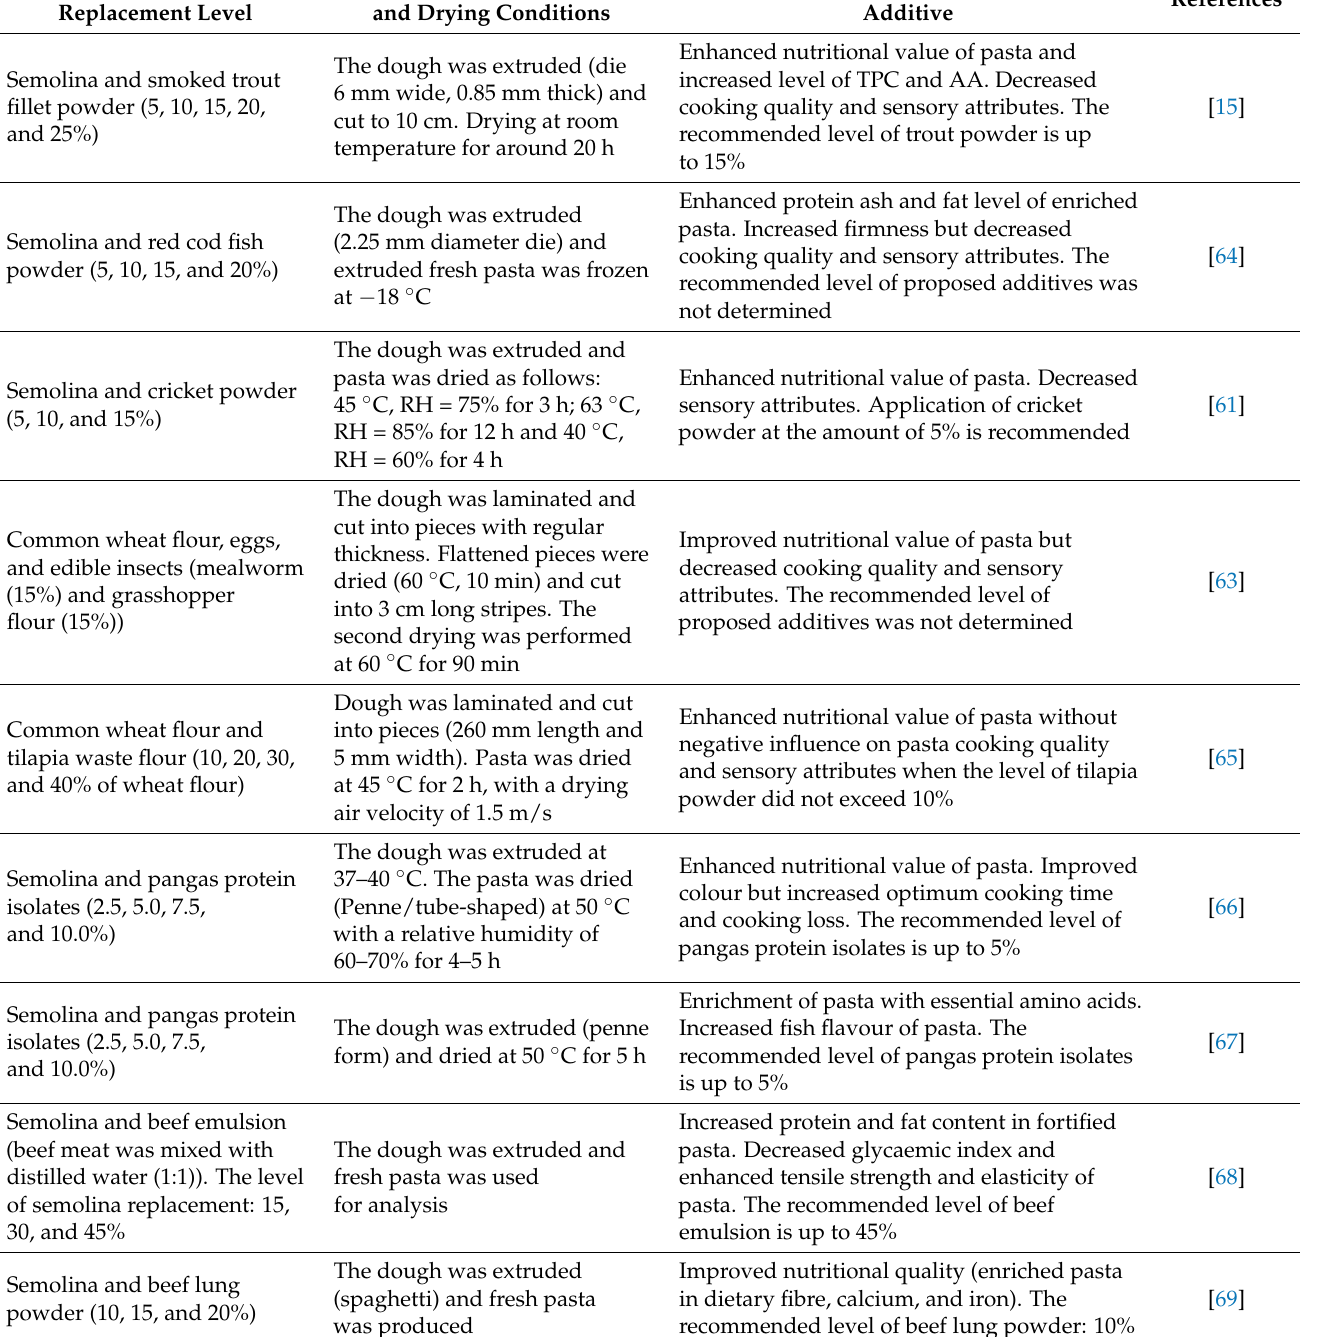
Table 3. Incorporation of powdered animal materials into pasta and its effect on pasta